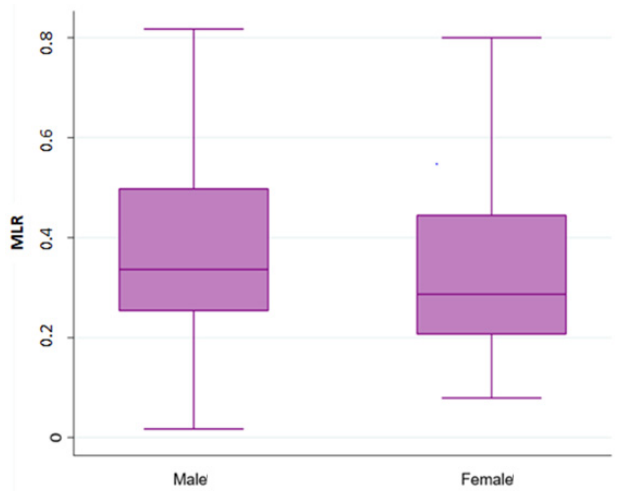
Figure 2. Association analysis between Monocyte-to-lymphocyte ratio (MLR) with gender.